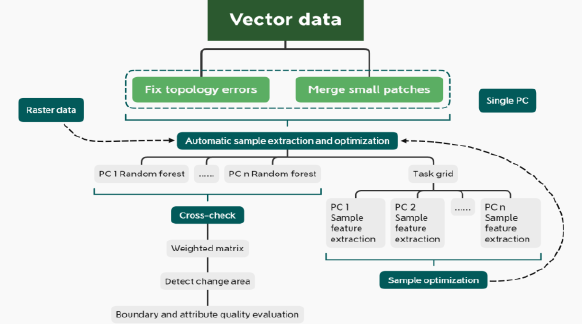
Figure 3. Quality control toolbox for object-oriented land change update supported by multiple